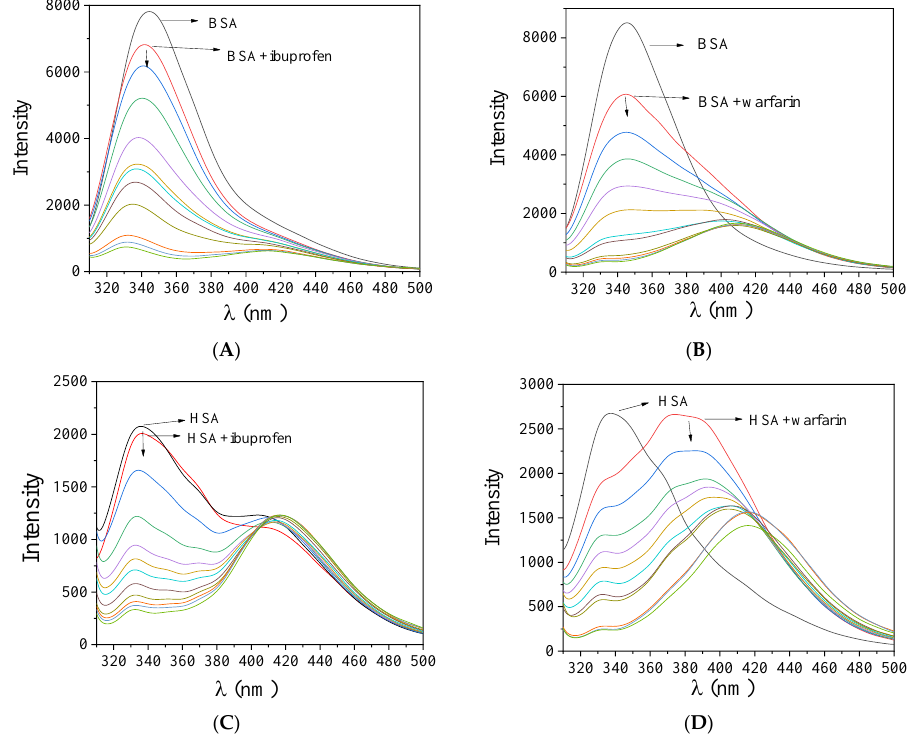
Figure 6. Fluorescence emission spectra (λ excitation = 295 nm) for BSA (3 μM) in the presence of ( A ) ibuprofen and ( B ) warfarin in buffer solution (150 mM NaCl and 15 mM trisodium citrate at pH 7.0) upon addition of increasing amounts of complex 1 and 2 , respectively . Fluorescence emission spectra (λ excitation = 295 nm) for HSA (3 μM) in the presence of ( C ) ibuprofen and ( D ) warfarin in buffer solution (150 mM NaCl and 15mM trisodium citrate at pH 7.0) upon addition of increasing amounts of complex 2 . The arrows show the changes of intensity upon increasing amounts of complex. Table 6. BSA- and HSA-binding constants of the compounds (K, in M −1 ) in the presence of the site probes warfarin and ibuprofen. Compound